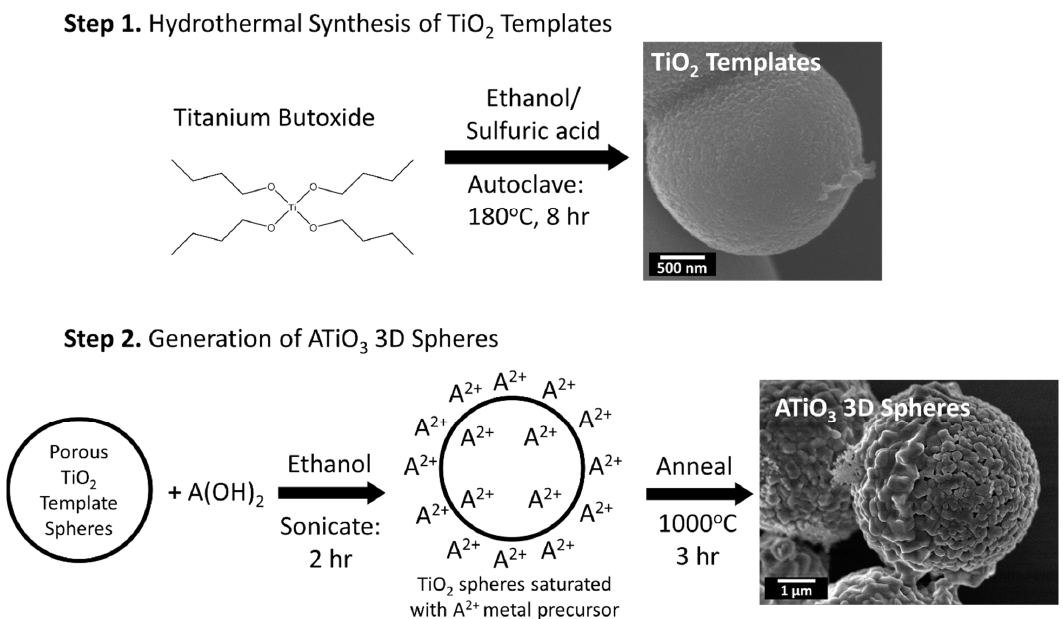
Figure 7. Proposed mechanistic flowchart, associated with the multi-step, surfactant-free synthesis of the as-prepared 3D ATiO 3 micron-scale spheres.